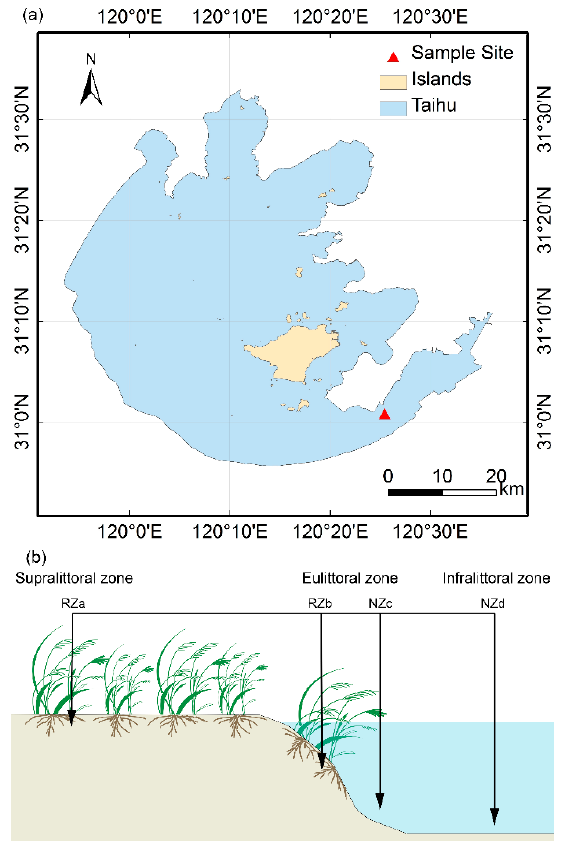
Figure 1. ( a ) Location of sampling site in lake Taihu, China, ( b ) the distribution of the four sampling zones, including, supralittoral zone with P. australis (RZa), eulittoral zone with P. australis (RZb), eulittoral zone without P. australis (NZc), infralittoral zone without P. australis (NZd).